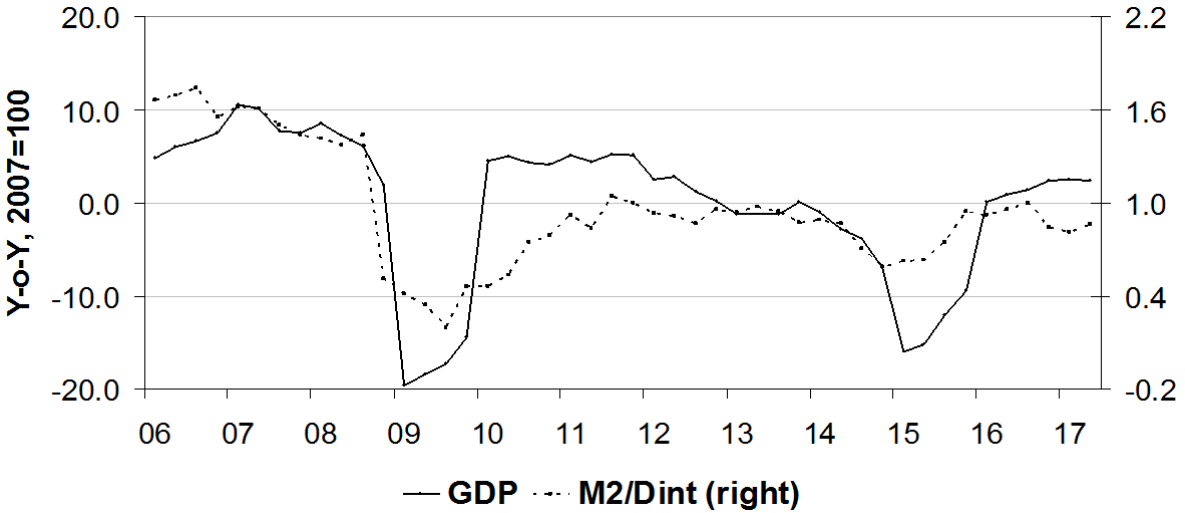
Figure 1. The comparative dynamics of GDP and the ratio of broad money (M2) to internal public debt (Dint) Source: State Statistics Service of Ukraine, National Bank of Ukraine, and State Treasury of